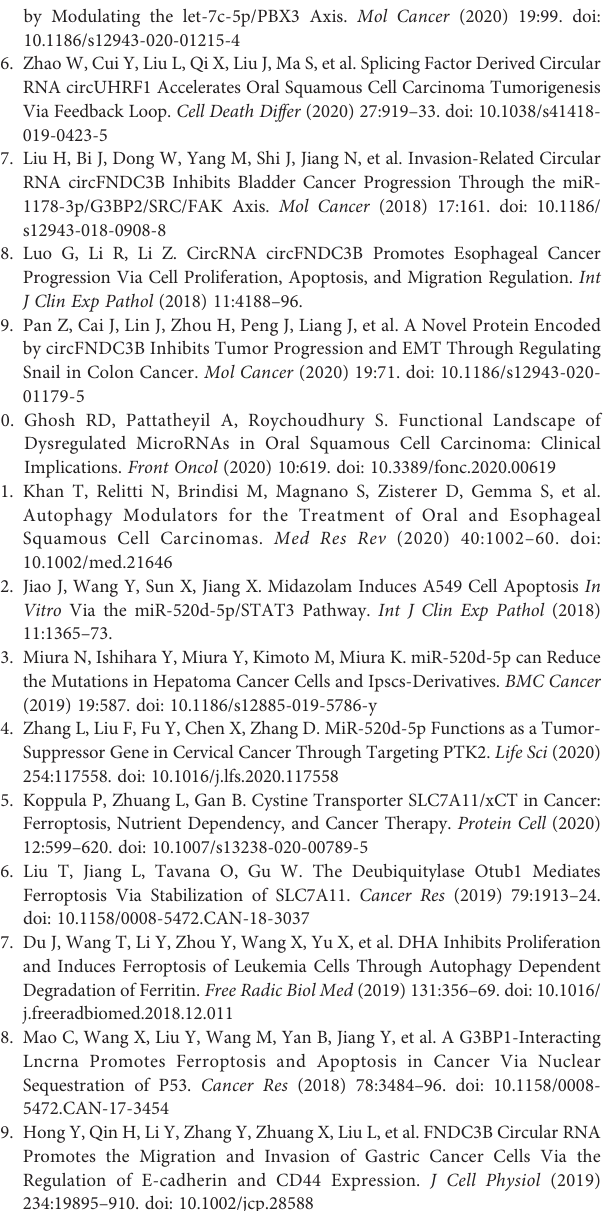
Supplementary Figure 1 | The validation of the effectiveness of circFNDC3B shRNA. (A) The circFNDC3B shRNA treated the CAL27 and SCC15 cells. (A) The RT-qPCR analysis of circFNDC3B expression. (B) CCK-8 assays of cell viability. N = 3, mean ± SEM: ** P <